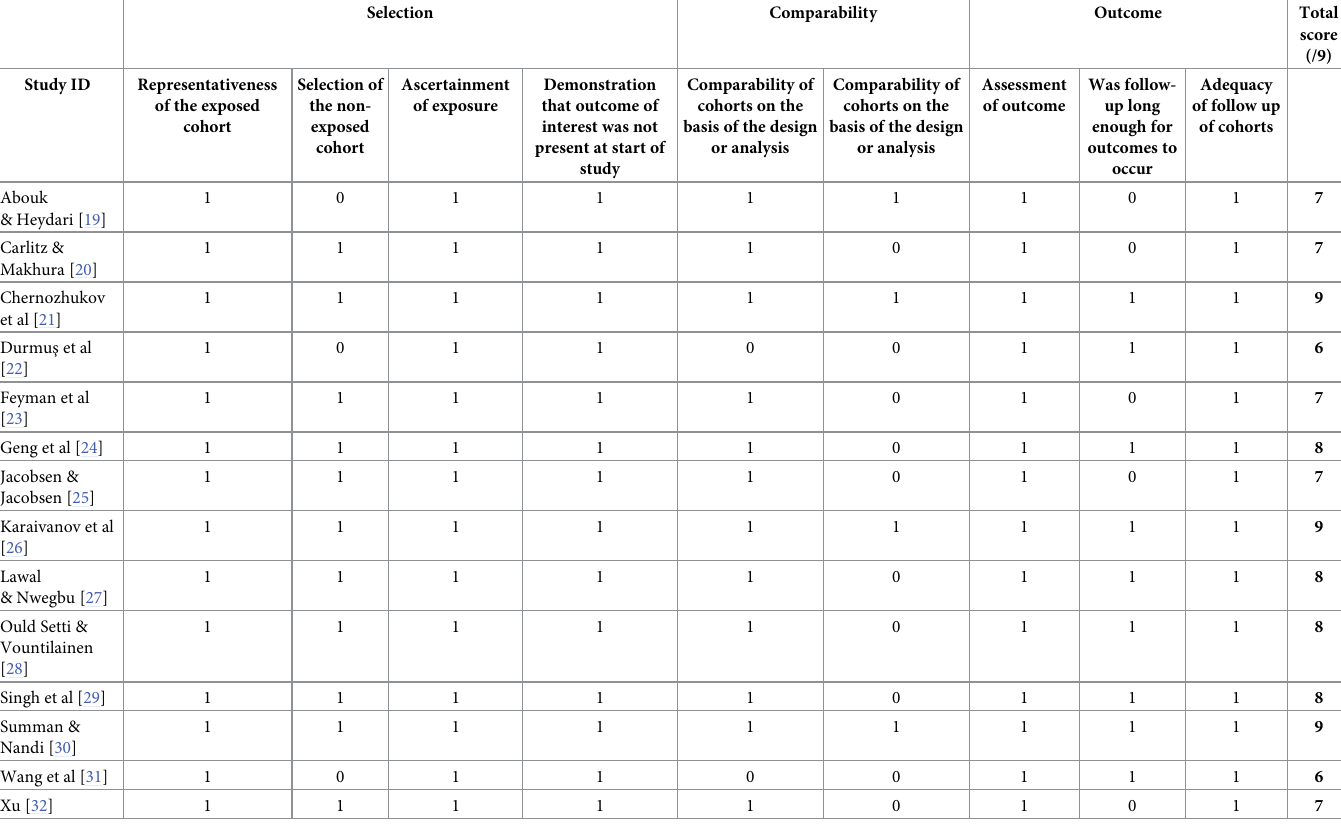
Table 2. Risk of bias of included